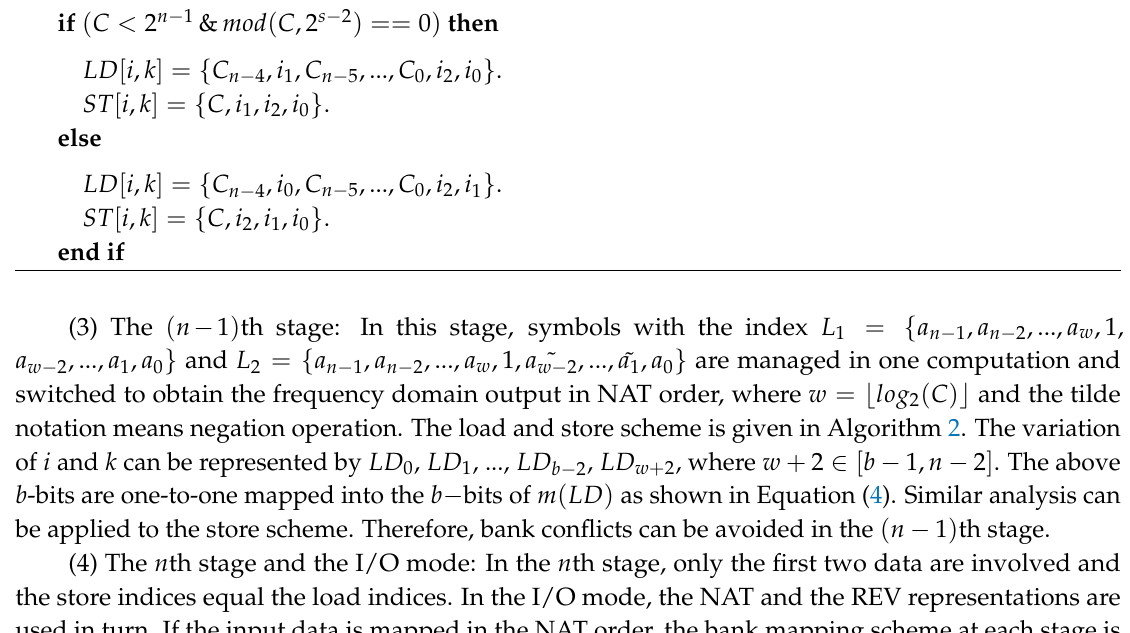
Algorithm 1 Load and store scheme of the [ 2, n − 2 ]